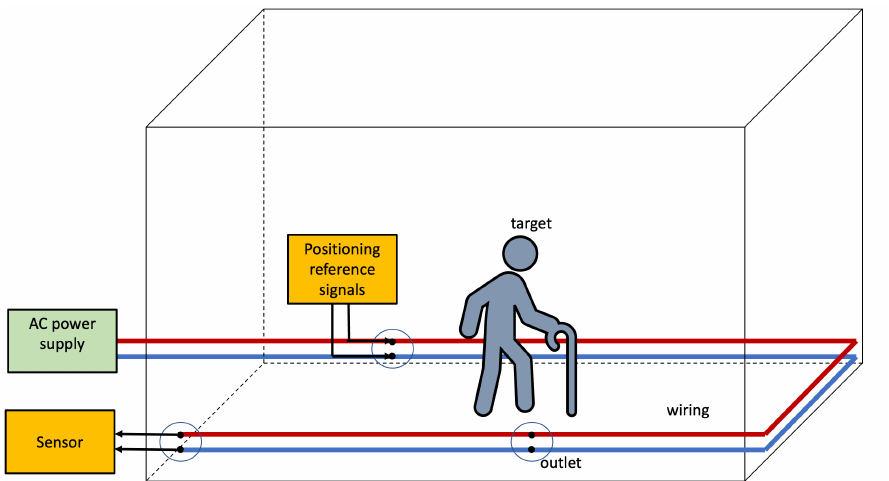
Figure 5. Infra-based and Target-obtuse unobtrusive PLPS architecture. The PLPS components are highlighted in yellow. In this scenario, the system estimates the position of the target whilst the target is